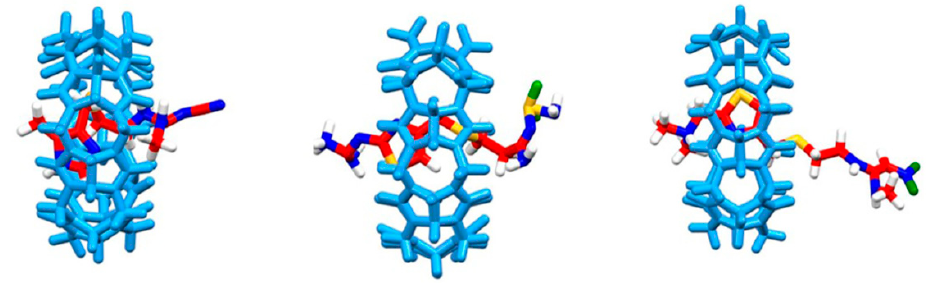
Figure 5. Snapshots of CT@CB[7] ( left ), FT@CB[7] ( middle ) and NT@CB[7] ( right ) at 30 ns.